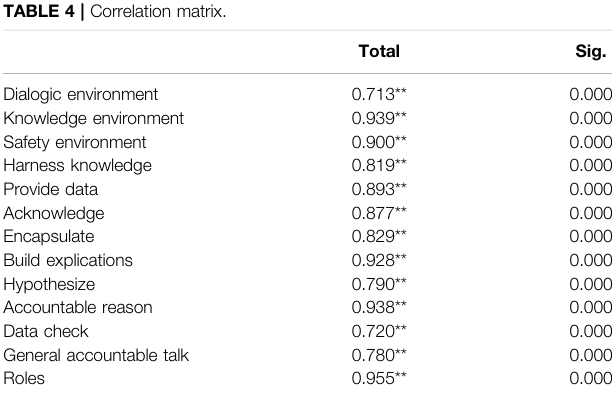
TABLE 4 | Correlation matrix.